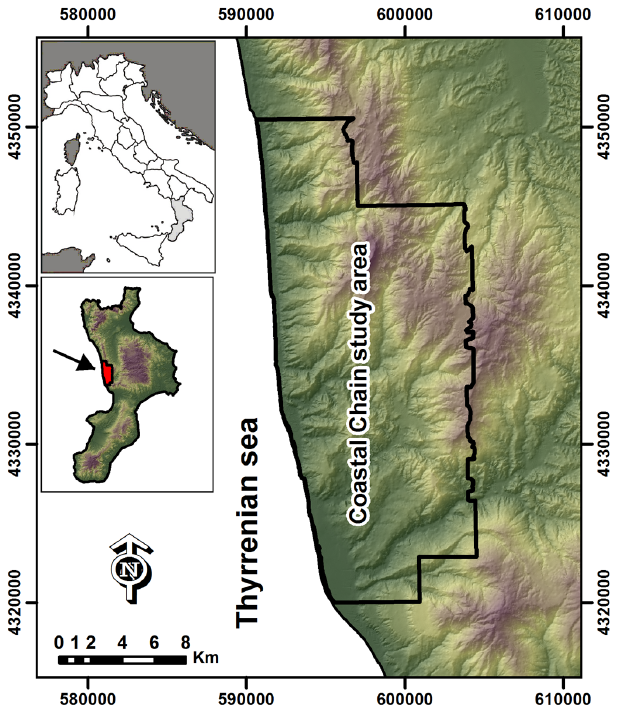
Fig. 1. Location of Coastal Chain study area (769500